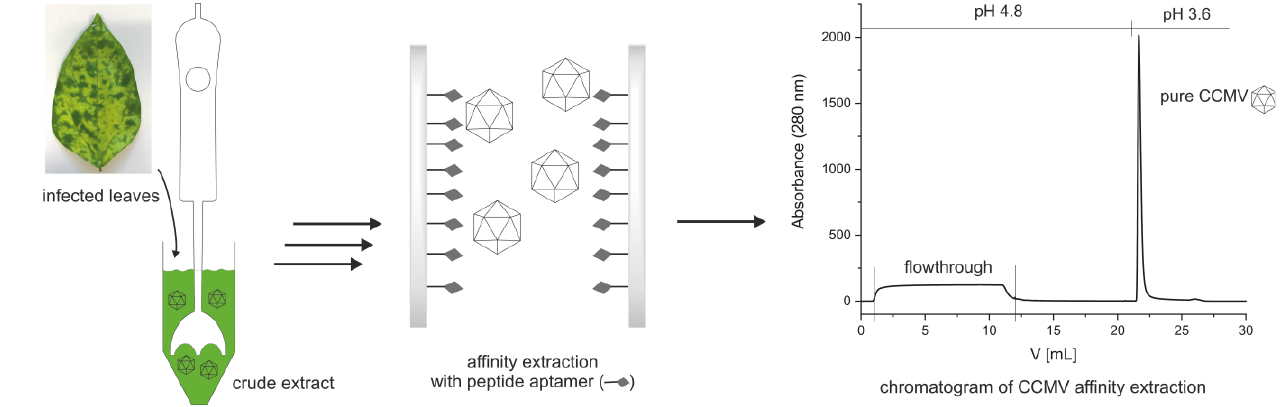
Figure 2. Simplified workflow for the purification of CCMV using a novel peptide aptamer.